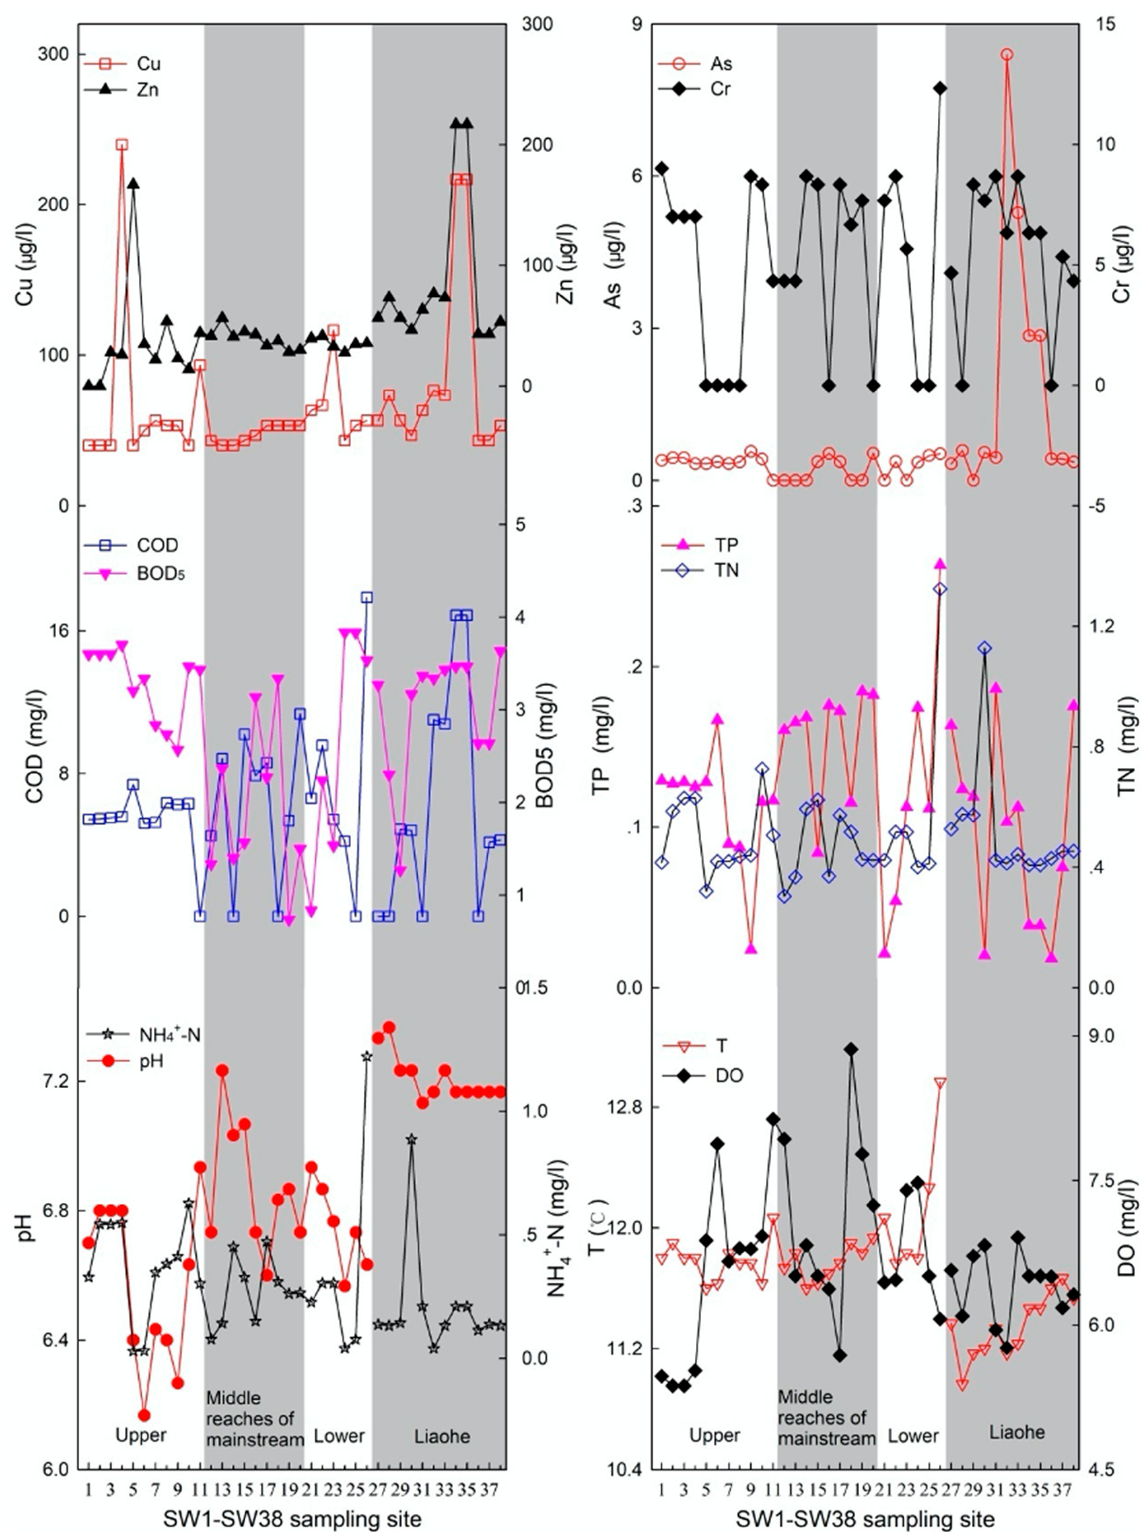
Figure 2. Spatial variation characteristics of the pH, nutrients, and heavy metals in the water samples obtained from the Xiujiang River.